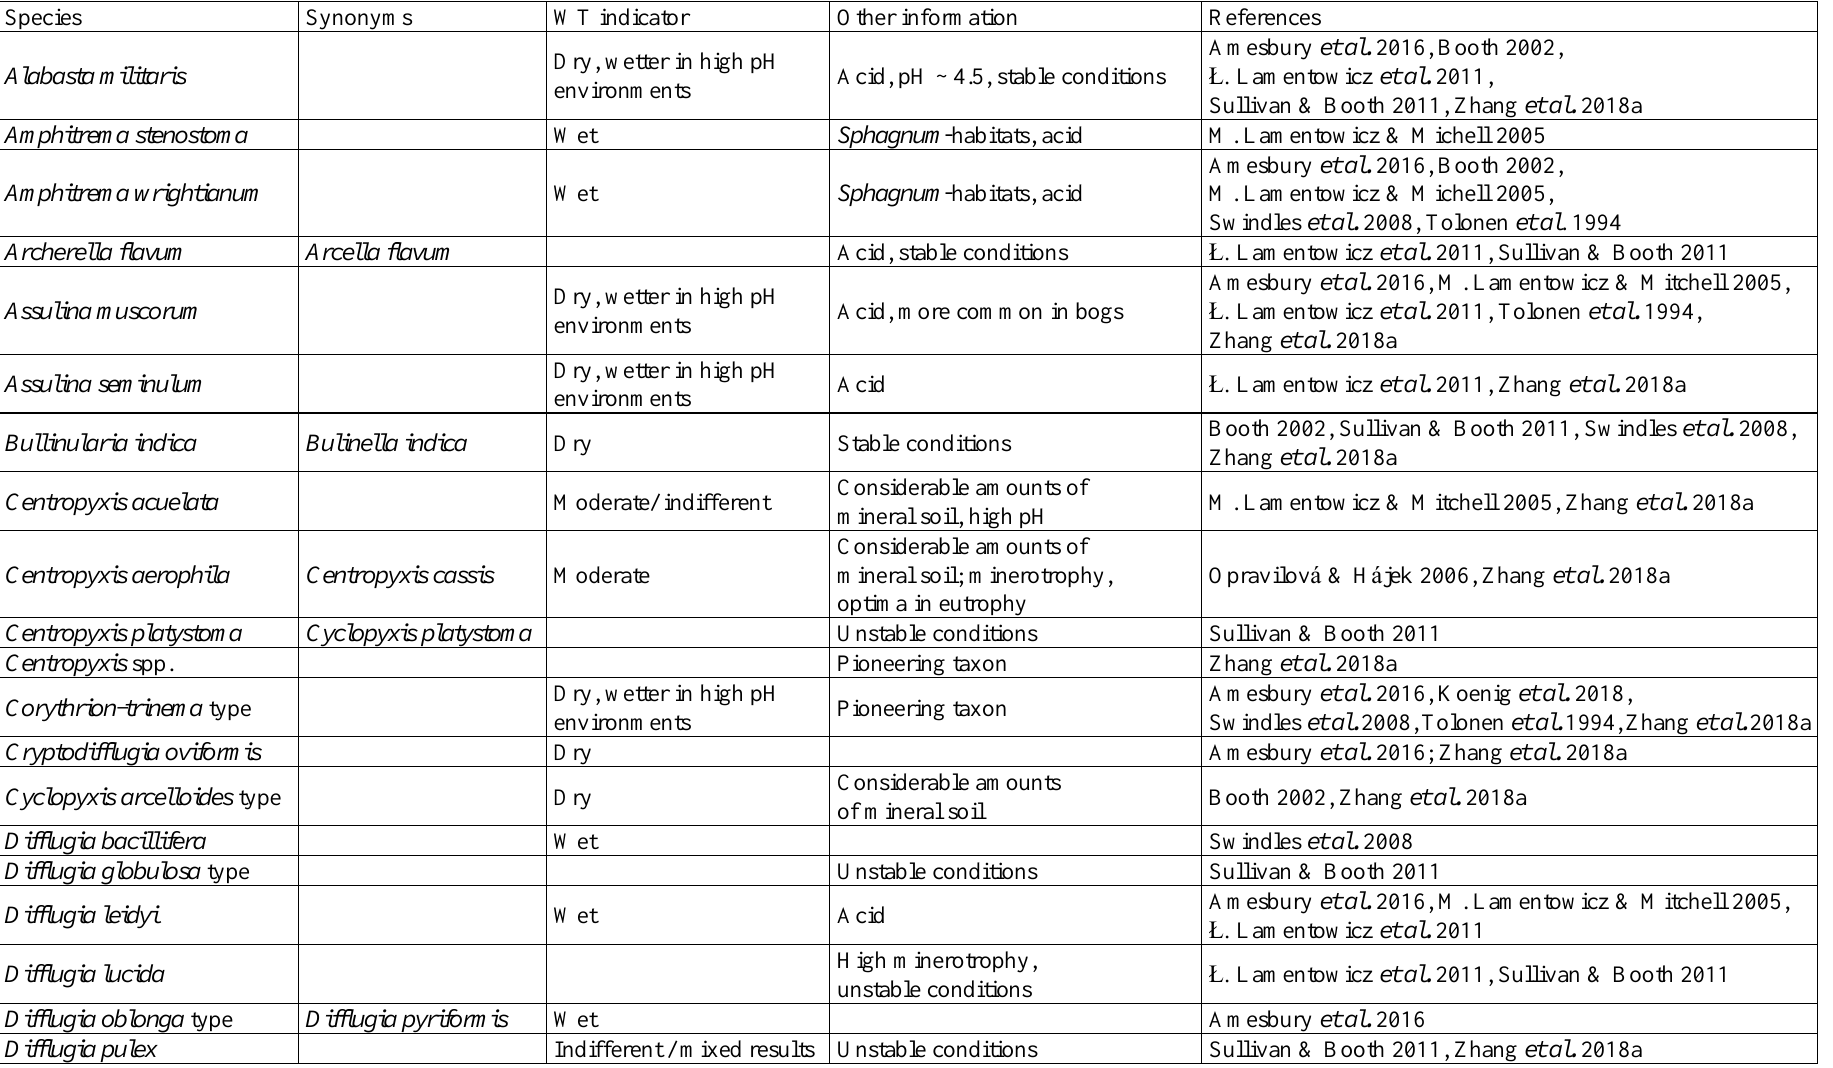
Table 1. Environmental preferences of selected testate amoeba taxa. Nomenclature according to Siemensta (2022).